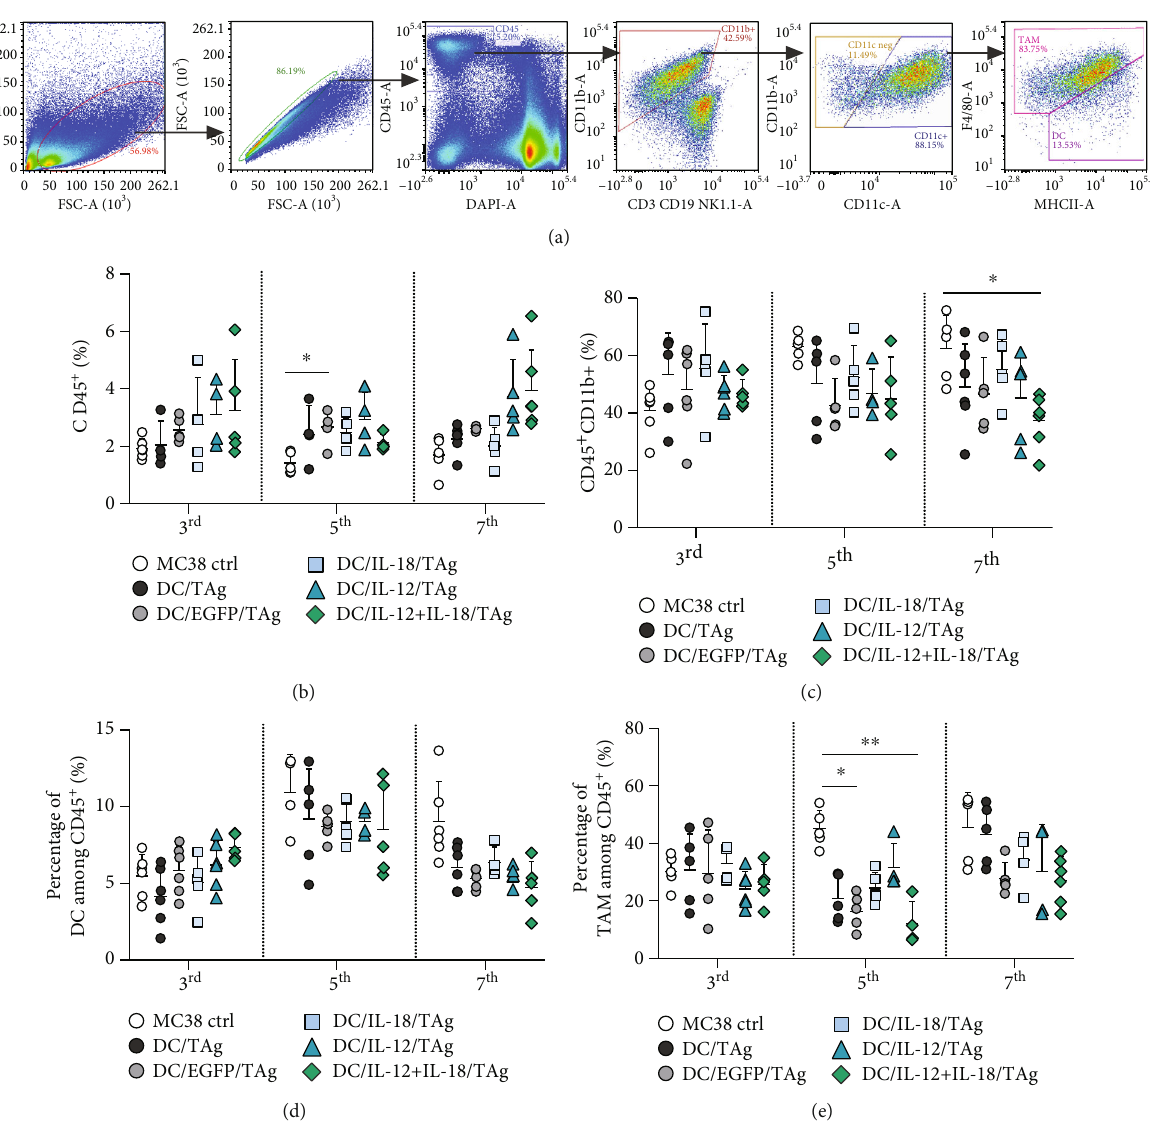
Figure 5: Evaluation of myeloid cell subpopulation in fi ltrating MC38 tumor tissue after administration of DC-based vaccines. (a) Scheme of the multiparameter fl ow cytometric analysis of DC and TAM in MC38 tumor nodules. The analysis was started by eliminating debris and cell aggregates; then, live leukocytes (DAPI - CD45 + ) were gated, and among them, CD11b + myeloid cells were identi fi ed. The CD11b + cells were subsequently separated for expression of the CD11c + marker. Among the CD11c + cells, the DC (CD11c + F4/80 int MHCII + ) and TAM (CD11c + F4/80 + ) population were identi fi ed. (b) Percentage of CD45 + cells in tumor tissue. (c) Percentage of CD45 + CD11b + cells in tumor tissue. (d) Percentage of DC in fi ltrating tumor tissue. (e) Percentage of TAM in tumor tissue. Results are presented as mean ± SD calculated for 5-6 mice per group. Di ff erences between groups were estimated using the nonparametric Kruskal-Wallis test followed by Dunn ’ s multiple comparison post hoc test ((e) percentage of TAM in tumor tissue on the 5th day), the parametric one-way ANOVA followed by Tukey ’ s multiple comparison post hoc test ((c) percentage of CD45 + CD11b + on the 7th day), or the parametric Brown-Forsythe and Welch ANOVA test followed by Dunnett ’ s T3 multiple comparison post hoc test ((b) percentage of CD45 + cells on the 5th day) ( ∗ p < 0 : 05 , ∗∗ p < 0 : 01